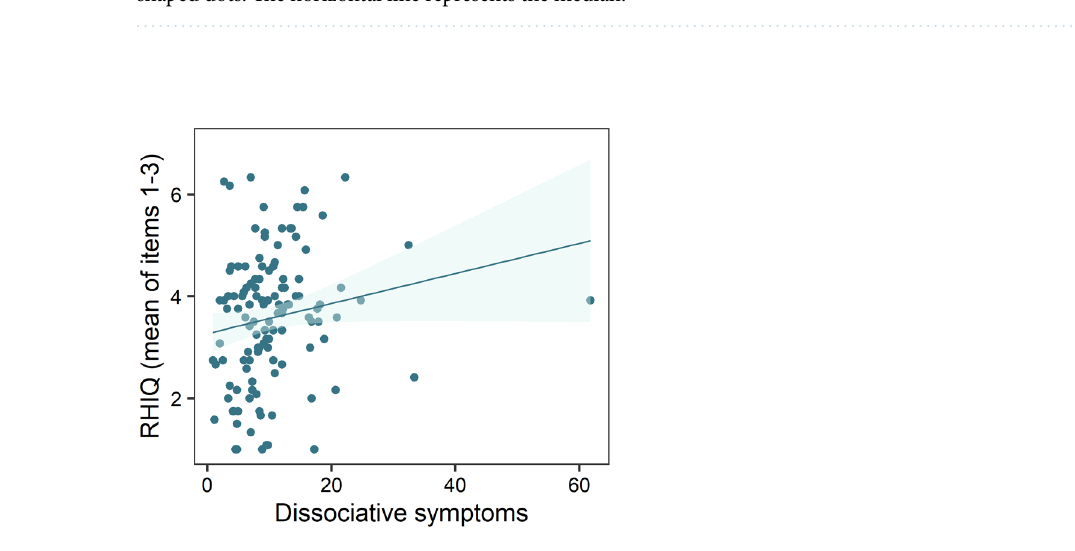
Figure 5. Regression graph for the main effect of dissociative symptoms on the mean RHIQ scores, averaged across all